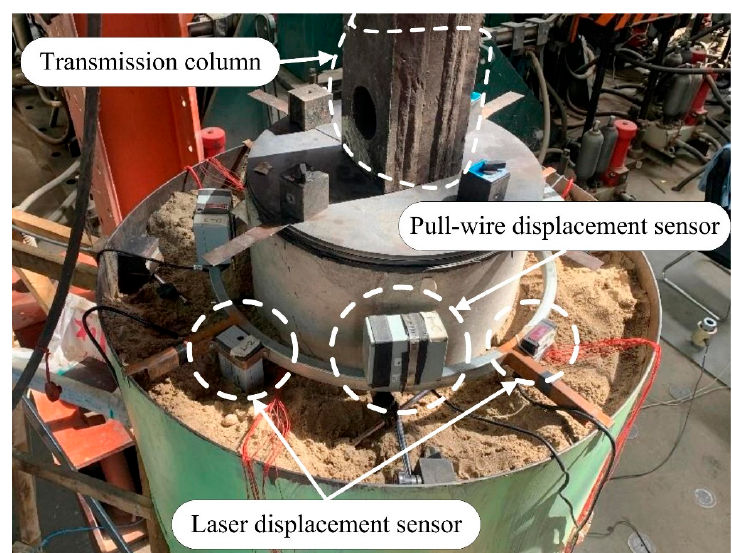
Figure 5. Schematic of the experimental device.